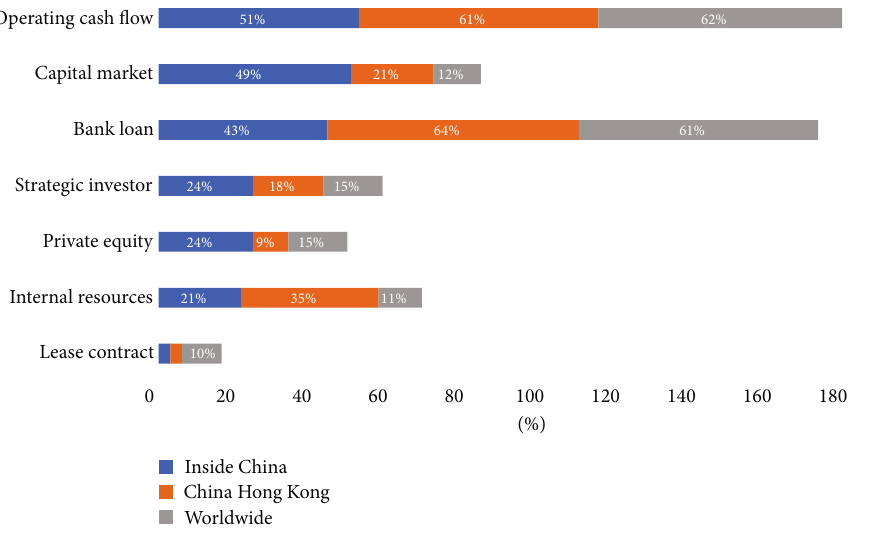
Figure 3: Existing and planned sources of fi nancing for family